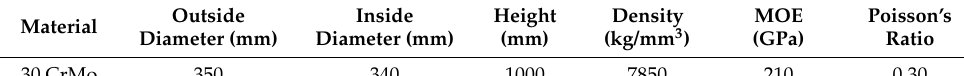
Figure 5. Experimental system.